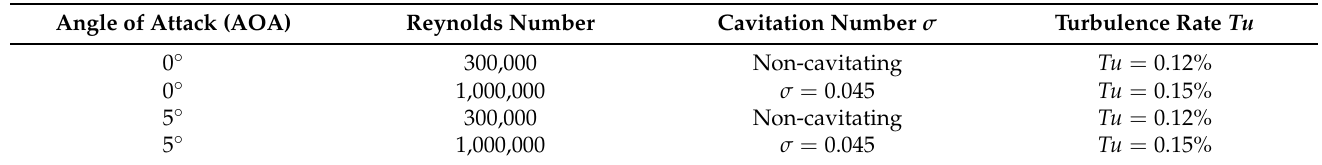
Table 1. Studied conditions of the NACA 16012 foil.